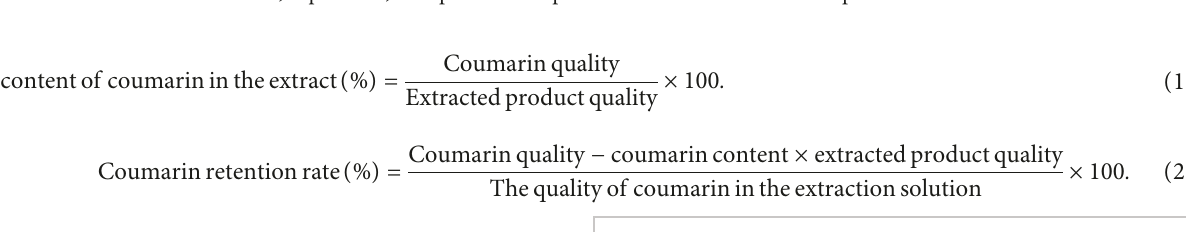
Figure 3: Extraction, separation, and purification process route of coumarin compounds in C. chinensis